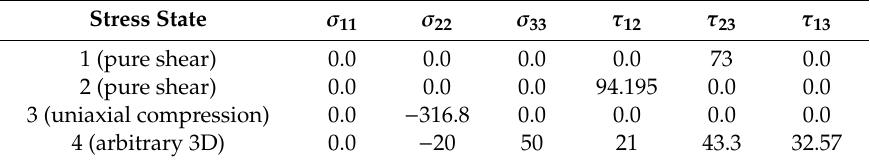
Table 1. Four typical stress states for IM7 / 8552 composite (units: MPa).